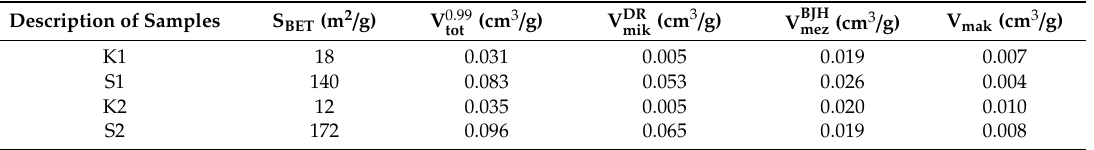
Table 5. The results of an analysis of the specific surface and porosity of materials after the calcination process and after synthesis, depending on the sampling point.